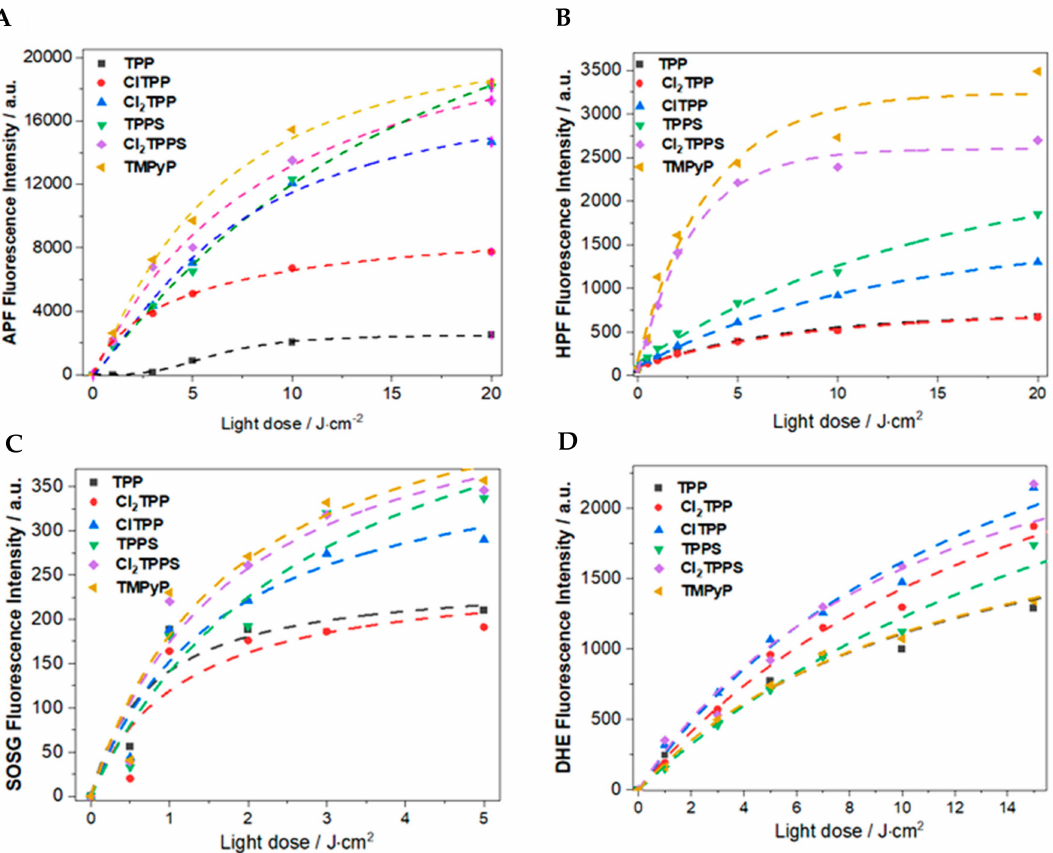
Figure 7. Photogeneration of ROS: the fluorescence intensity from ROS probes (10 µ M), namely, APF ( A ), HPF ( B ), SOSG ( C ), and DHE ( D ), during irradiation of a porphyrin solution with a 420 nm